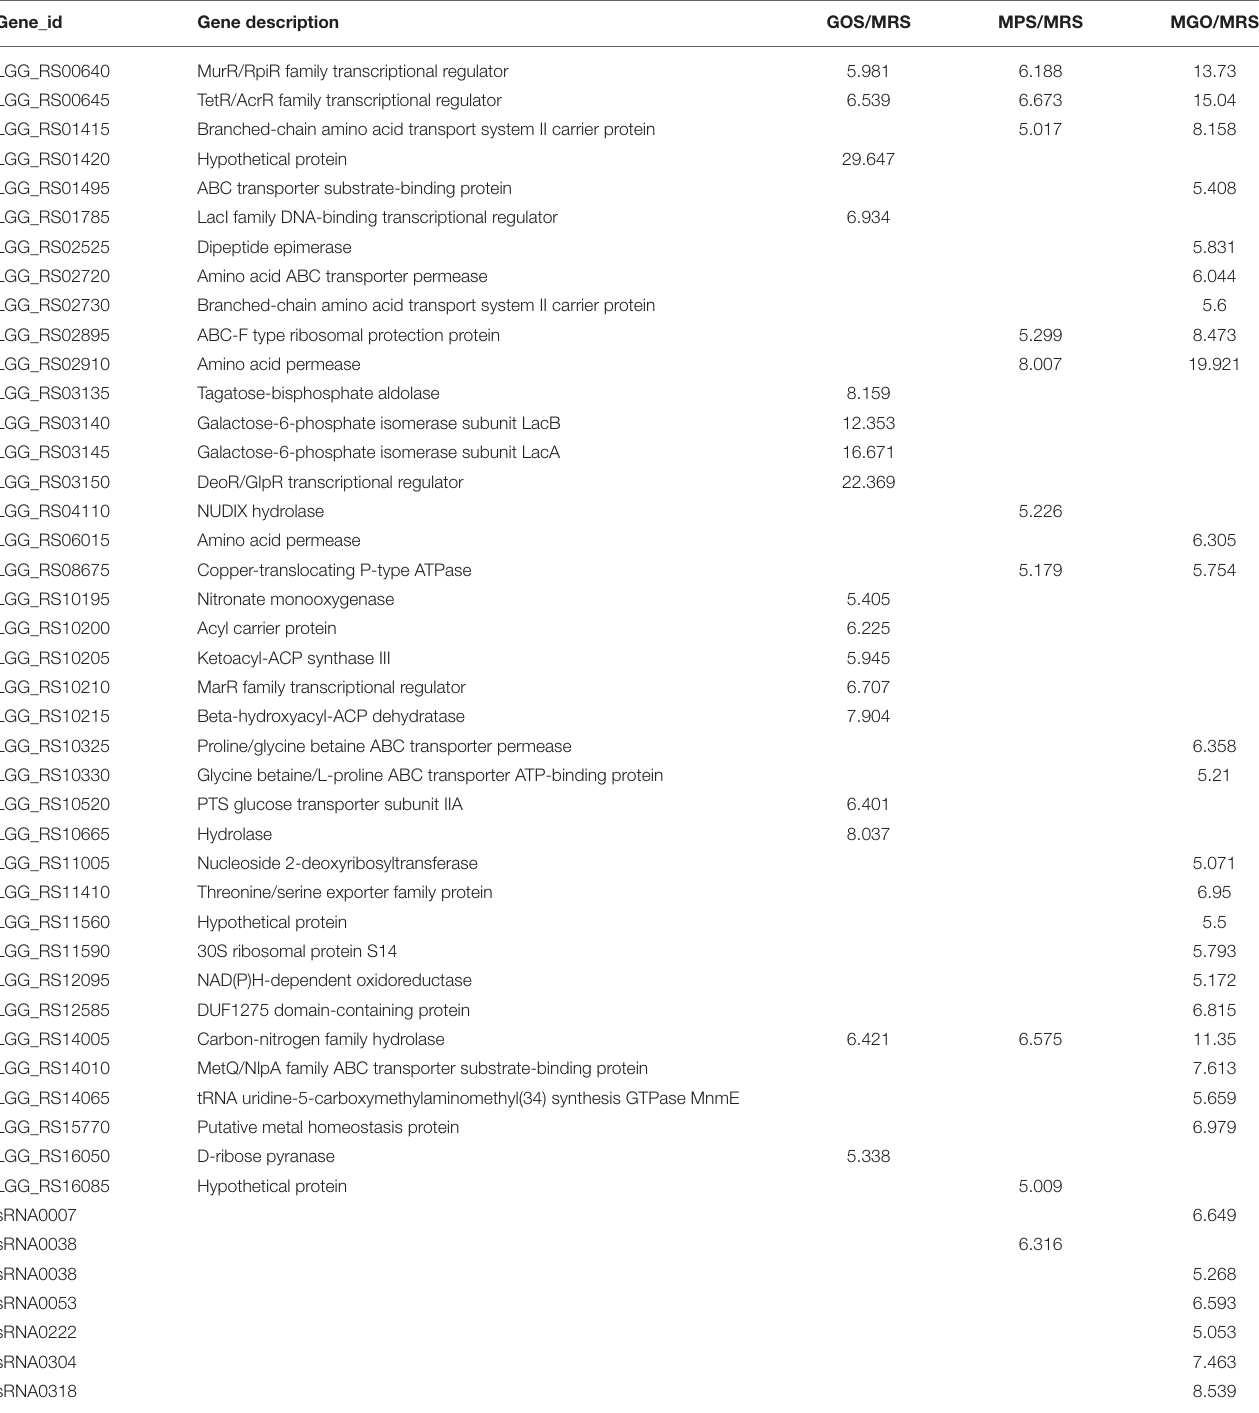
TABLE 2 | Differentially expressed genes (fold change > 5) of LGG cultured for 24h in different prebiotic media. Gene_id Gene